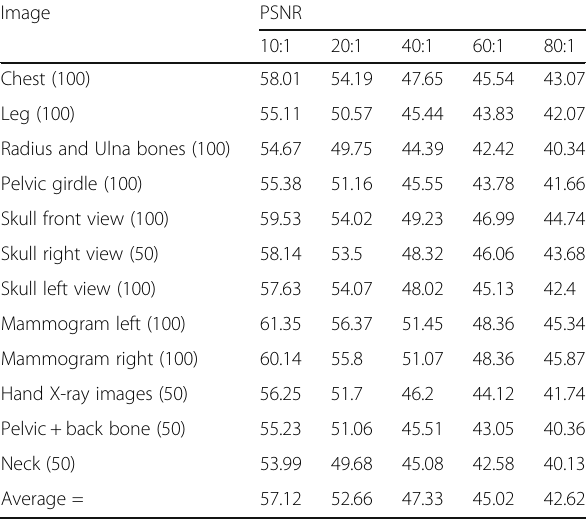
Table. 1 CR and PSNR values obtained for DB1 (codebook